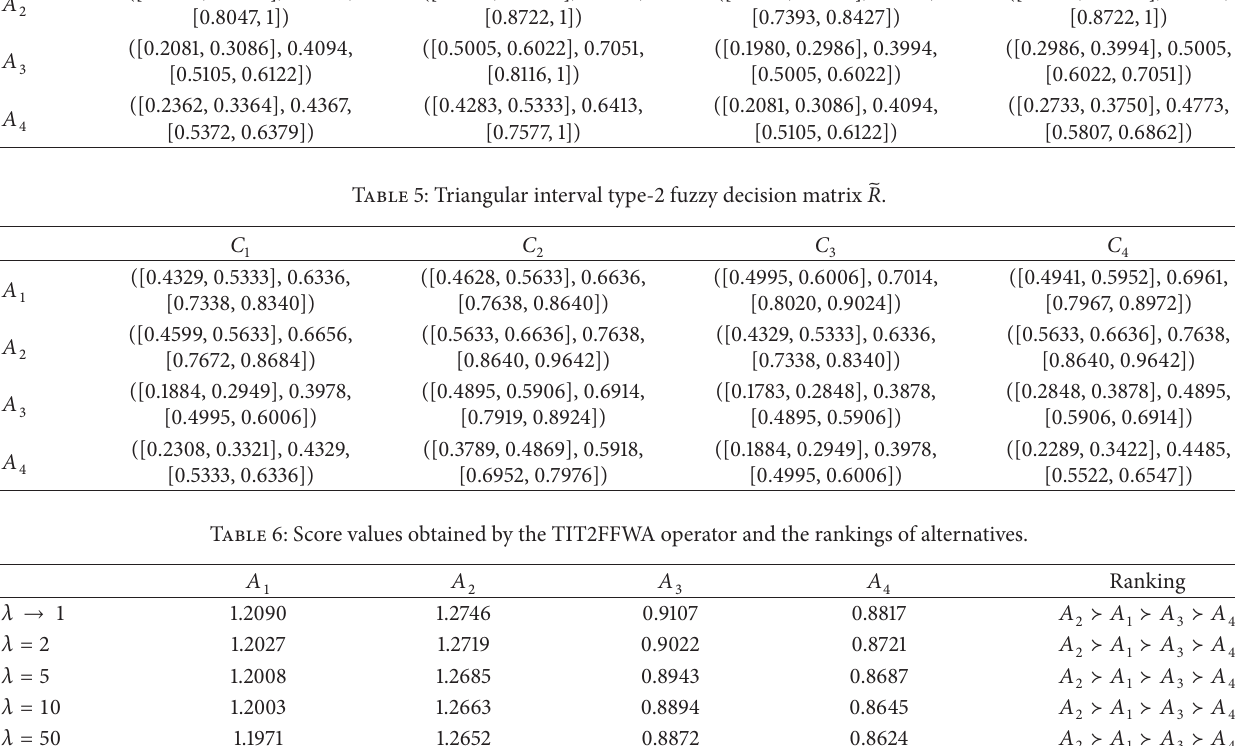
Table 4: Triangular interval type-2 fuzzy decision matrix